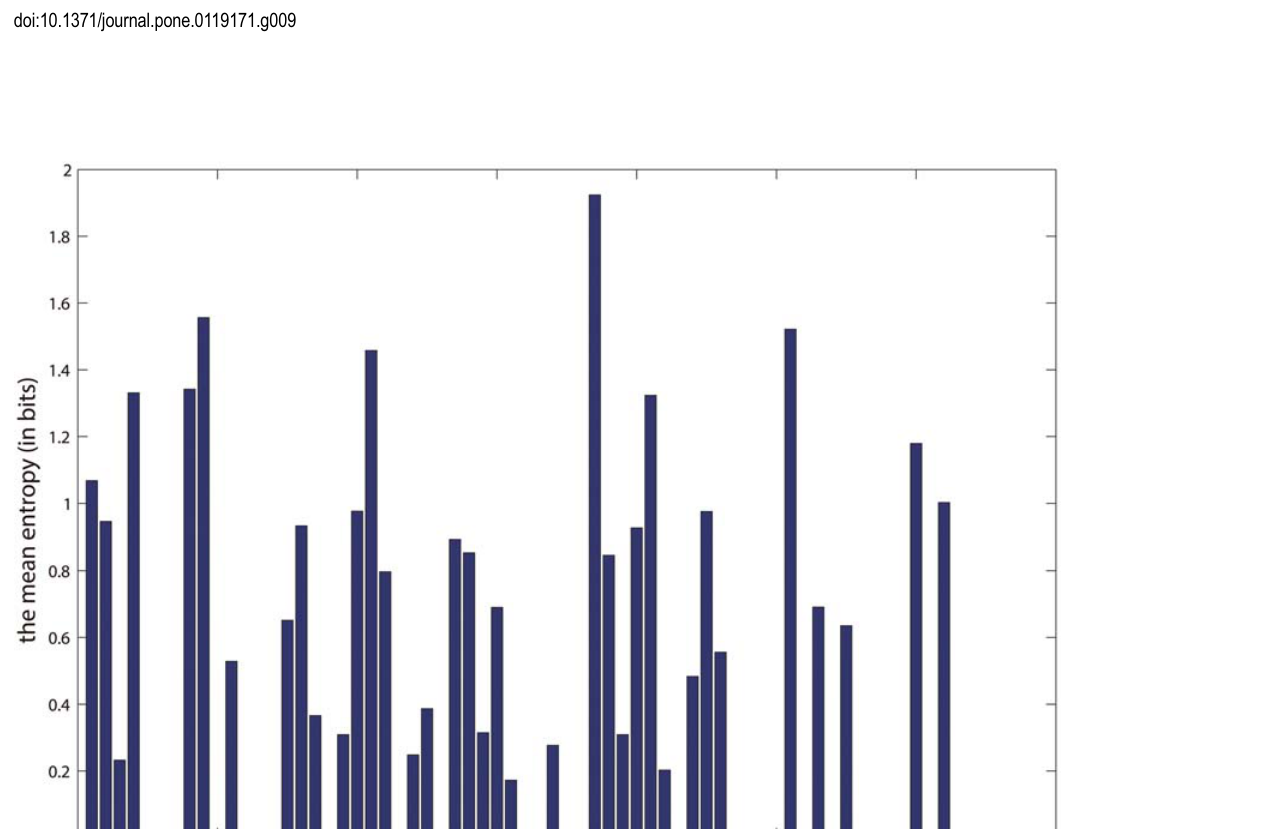
PLOS ONE | DOI:10.1371/journal.pone.0119171 March 30, 2015 18 /